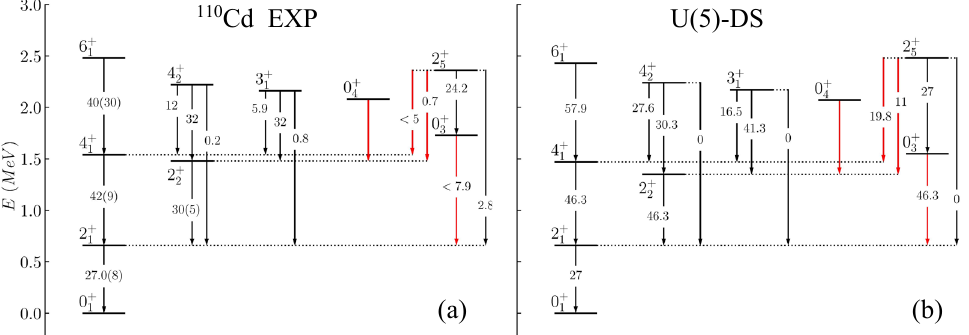
Figure 1. (a) Experimental spectrum and representative E2 rates [2, 6] (in W.u.) of normal levels in 110 Cd. (b) U(5)-DS spectrum obtained from ˆ H DS (2) with parameters t 1 = 641 . 5 , t 2 = 67 . 9 , t 3 = 26 . 1 , t 4 = 8 . 7 keV and N = 7. The E2 operator is e B ˆ Q , Eq. (4), with − e B = 1 . 96 (W . u . ) 1 / 2 . For additional experimental error bars on B(E2) values, not shown in Figs. 1(a) and 2 (a), see [2, 6].